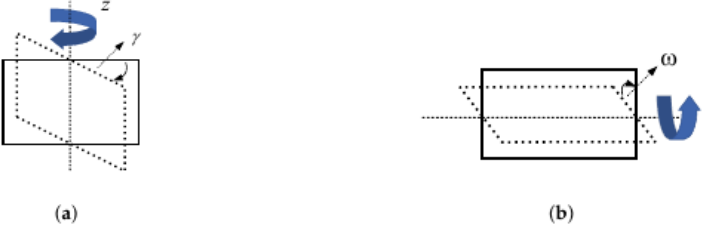
Figure 2. ( a ) The mirror’s yaw rotation angle. ( b ) The mirror’s roll rotation